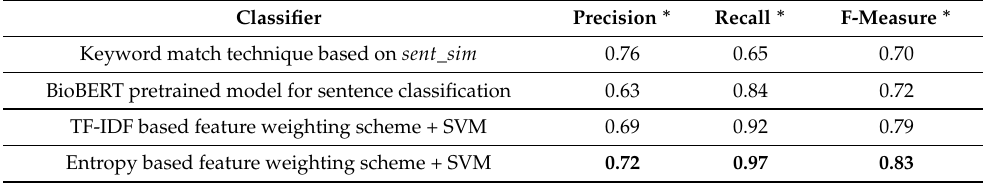
Table 4. Performance of different sentence extraction techniques.